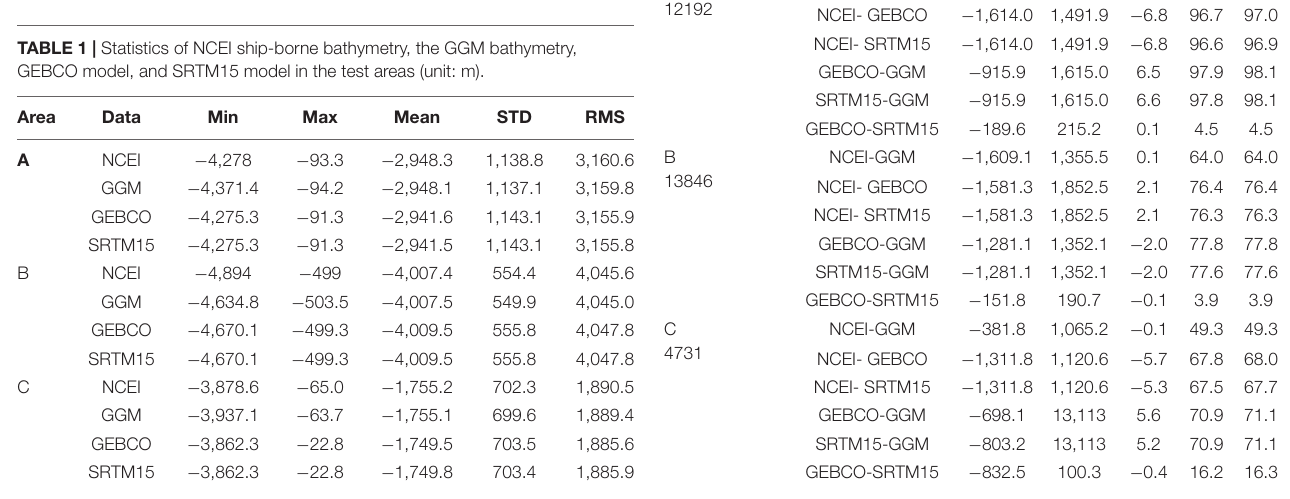
TABLE 2 | Statistics of differences among the NCEI bathymetry, the GGM bathymetry, GEBCO model and SRTM15 model in the check points (unit: m). Area/check